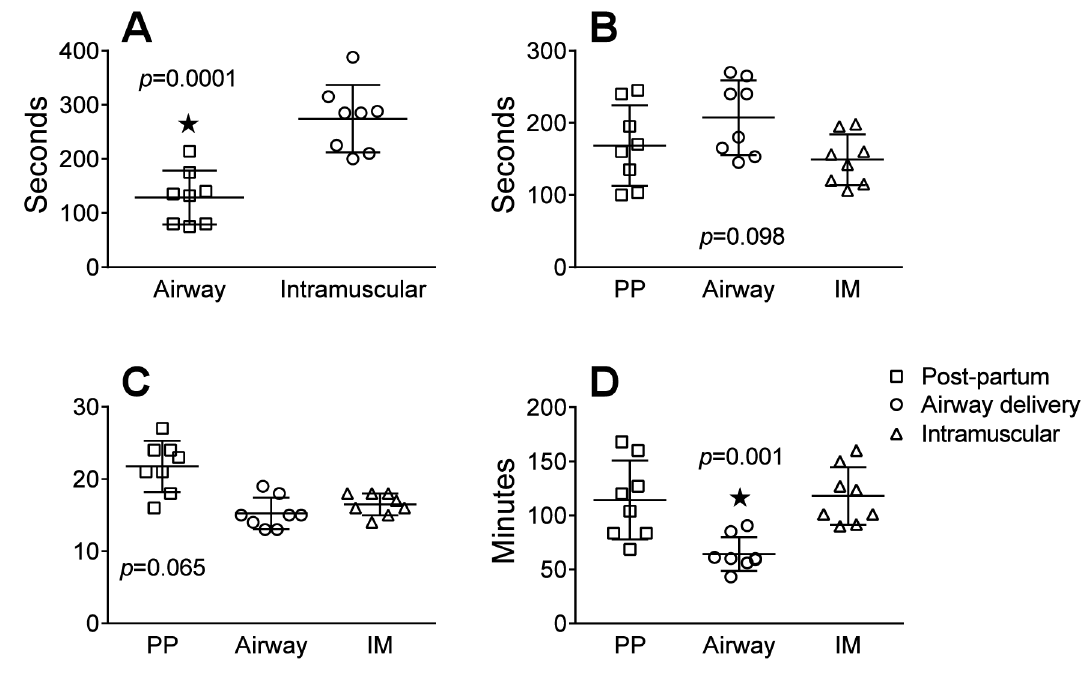
Figure 6. Parameters derived from electromyograph uterine activity in response to